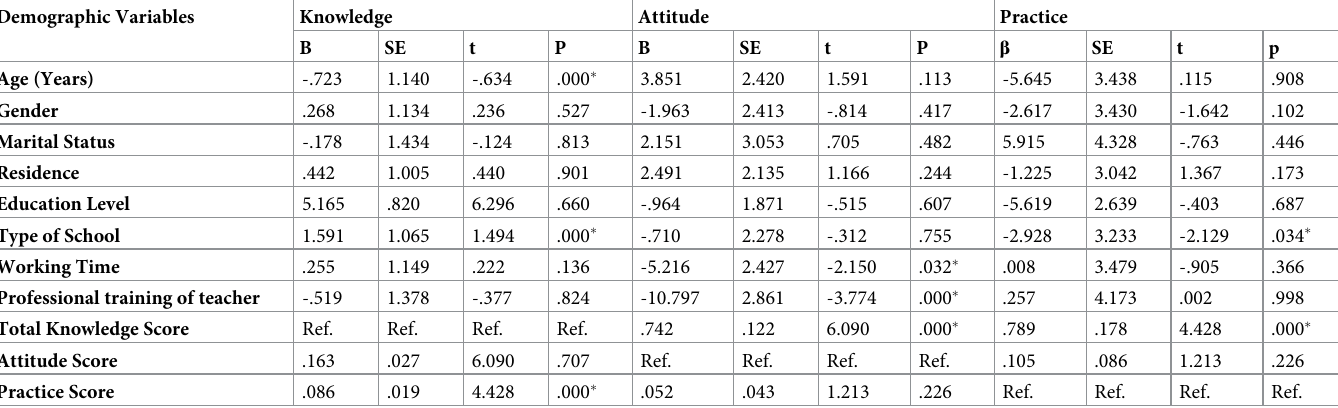
Table 5. Multiple linear regressions to identify factors that affect obesity-related knowledge, attitude & practice. Demographic Variables